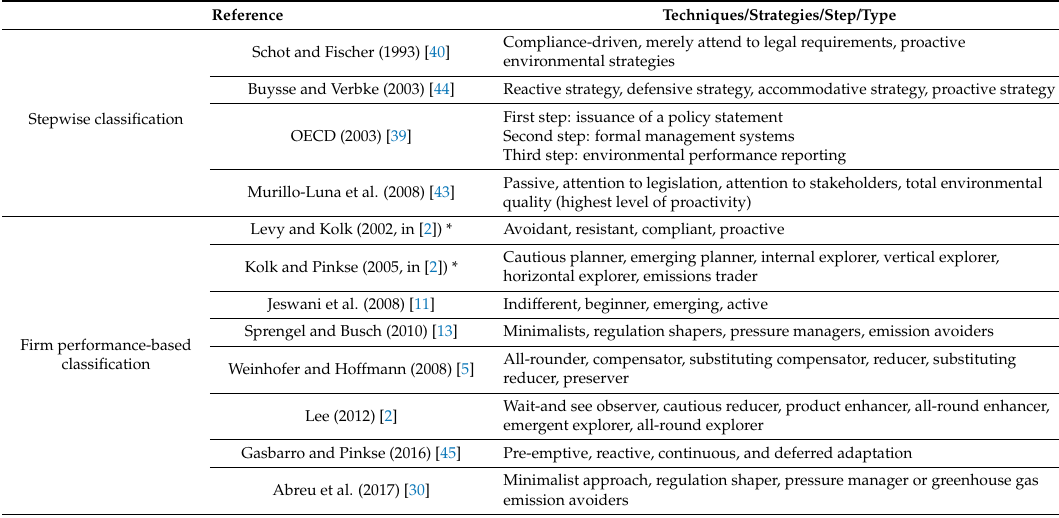
Table 1. Literature on the classification of a company’s environment and carbon